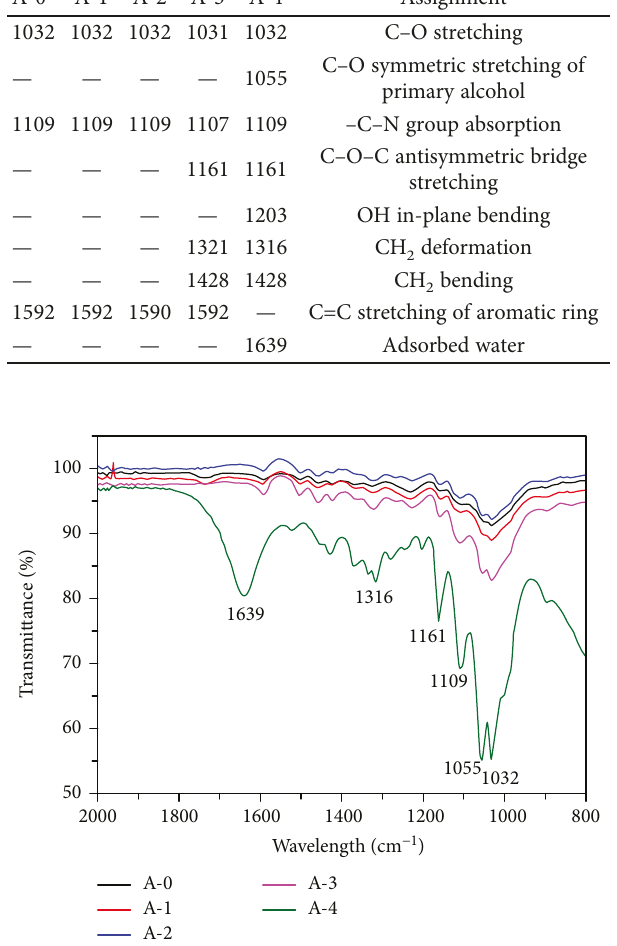
Figure 5: TGA spectra of cellulose prepared from the wood of Eucalyptus lenceolata